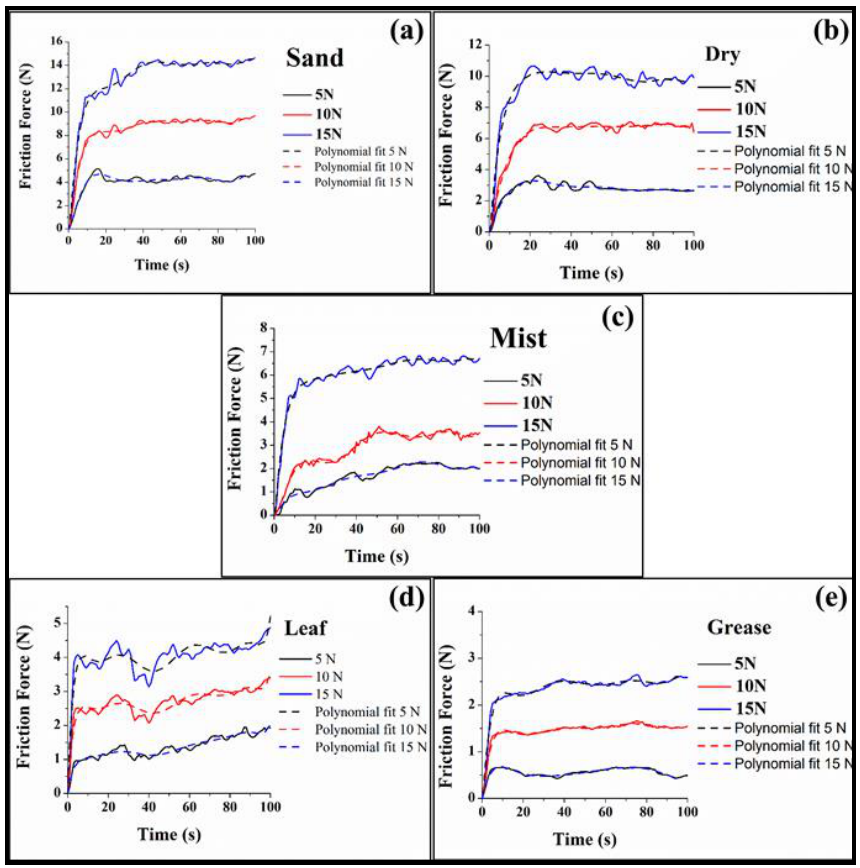
Figure 7. Effect of load on friction force for ( a ) sand, ( b ) dry, ( c ) mist, ( d ) leaf, and ( e )